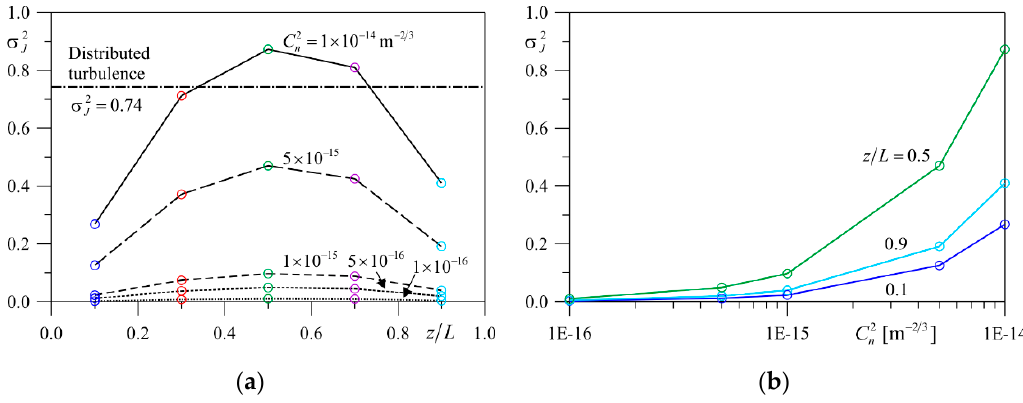
σ on the relative position Figure 5. ( a ) Dependencies of the TILAS received power signal variance 2 Figure 5. ( a ) Dependencies of the TILAS received power signal variance σ 2 on the relative position J J z / L of a single turbulence layer of different turbulence strengths, z / L of a single turbulence layer of di ff erent turbulence strengths, C 2 n = 10 − 14 m − 2/3 , 5 × 10 − 15 m − 2/3 , − , denoted by solid, long-dashed, dashed, short-dashed, and 10 − 15 m − 2/3 , 5 × 10 − 16 m − 2/3 , and 10 − 16 m − 2/3 , denoted by solid, long-dashed, dashed, short-dashed, σ obtained for the distributed and dotted lines, respectively. The dash-dotted black line shows σ 2 obtained for the distributed dotted lines, respectively. The dash-dotted black line shows 2 J J turbulence model with C 2 n = 2 × 10 − 15 m − 2/3 ( r 0 = 4.1 cm). ( b ) Dependencies of the power signal C − − = × ( r 0 = 4.1 cm). ( b ) Dependencies of the power signal turbulence model with 2 15 2/3 2 10 m n variance σ 2 on C 2 n for di ff erent relative positions of the layer, z / L = 0.1, 0.5, and 0.9, denoted by blue, σ on 2 C for different relative positions of the layer, z / L = 0.1, 0.5, and 0.9, denoted by variance 2 J n J green, and sky-blue lines. Other parameters are the same as in Figure blue, green, and sky-blue lines. Other parameters are the same as in Figure 3.